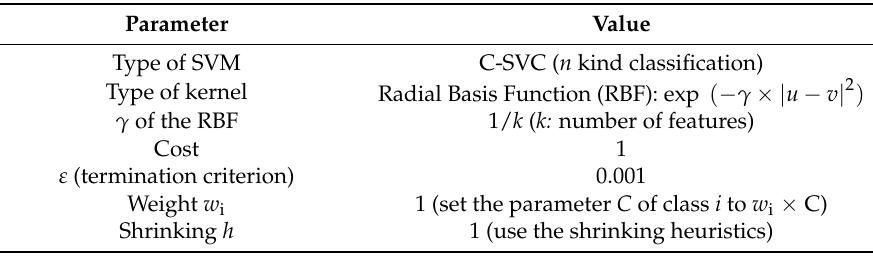
Table 3. Parameter settings of the support vector machine (SVM).